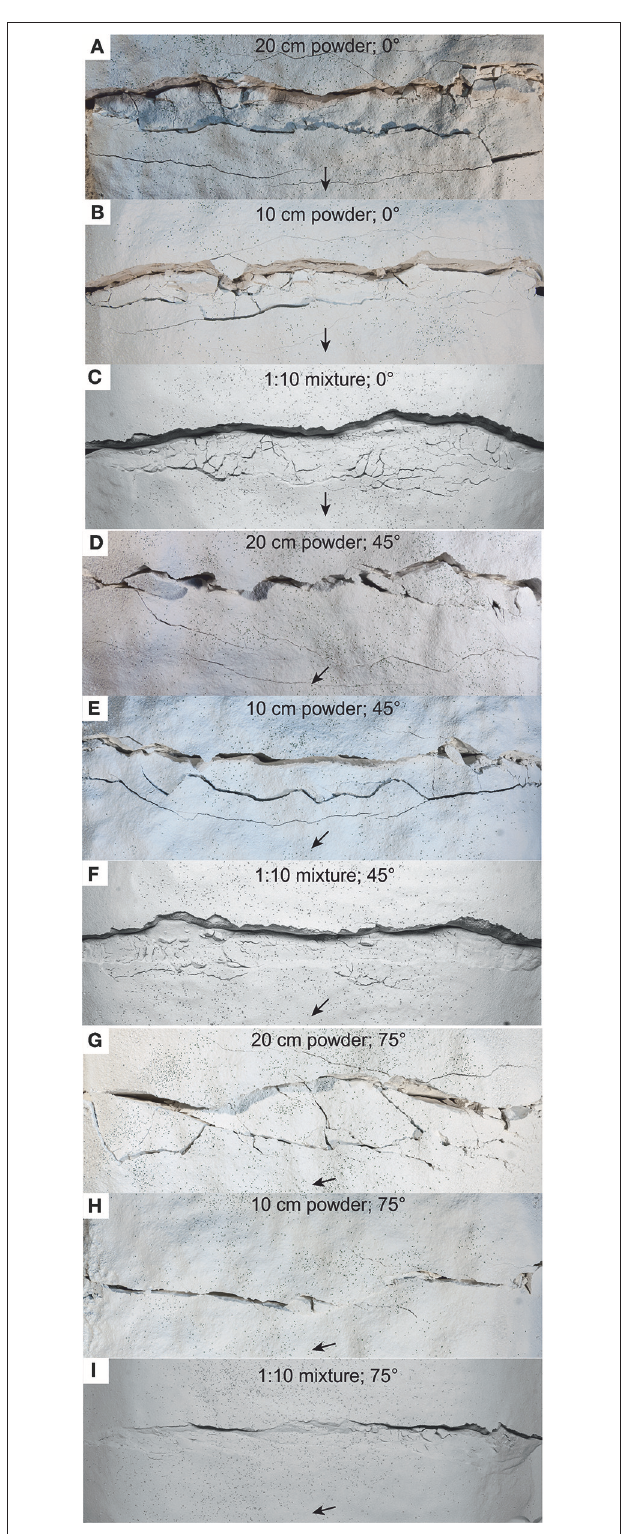
FIGURE 8 | Comparison between experiments with different powder thickness and material strength. (A–C) Experiments with 0 ◦ obliquity. In 20 and